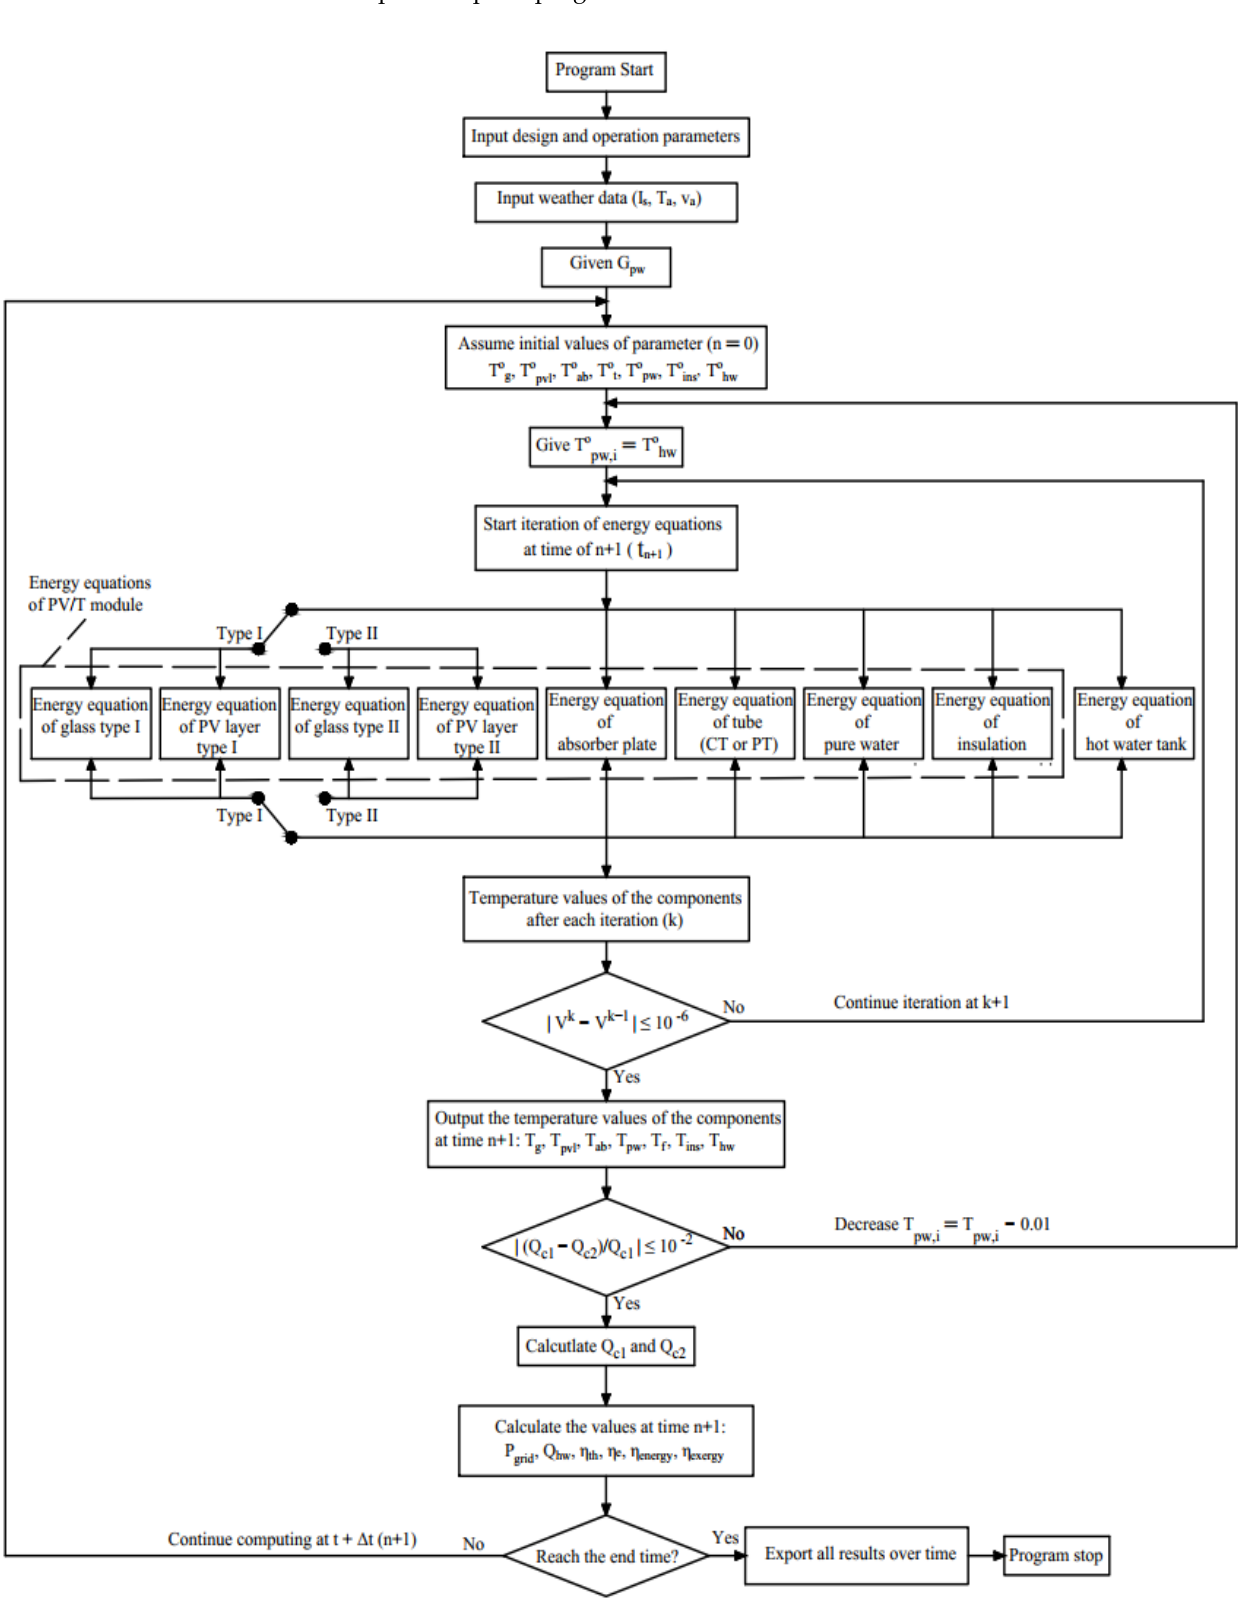
Figure 6. Simulation diagram for AWHS using PV/T module.